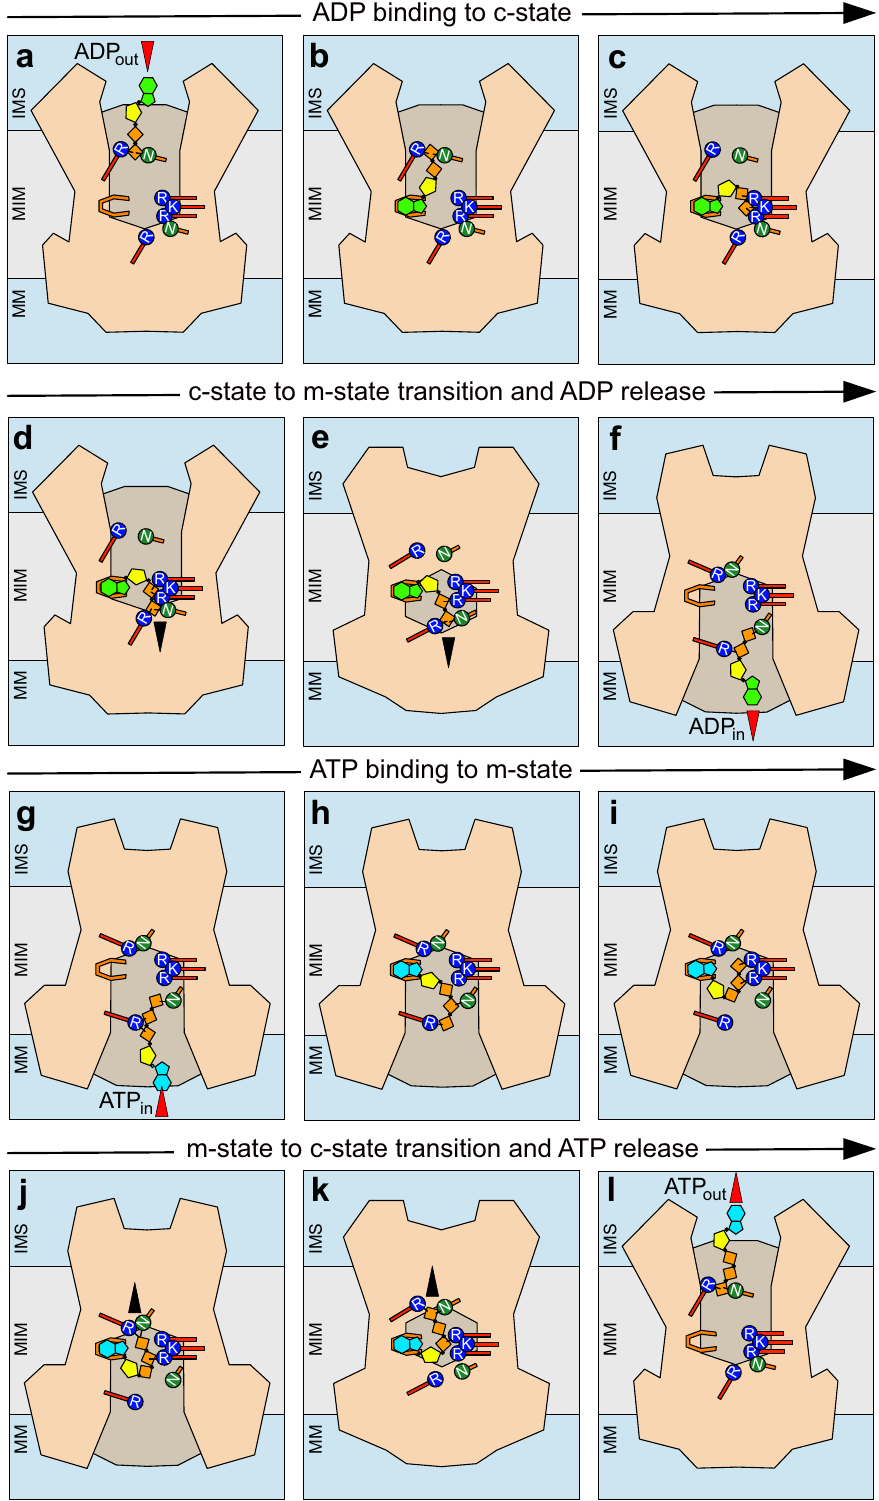
Fig. 7 Schematic representation of the substrate-binding events as part of the transport cycle. Different stages of the transport cycle, a – d , l cytoplasmic- open state, e , k occluded state, and f – j matrix-open state. The substrates ADP and ATP have an adenine moiety (green and cyan, respectively), a ribose moiety (yellow) and two or three phosphate moieties, respectively (orange). The adenosine binding site is represented by a horseshoe shape, whereas positively charged and polar residues of the binding site are shown in blue and green, respectively. The black arrowheads show the substrate movements that induce the conversion between states, whereas the red ones indicate entry and exit of the